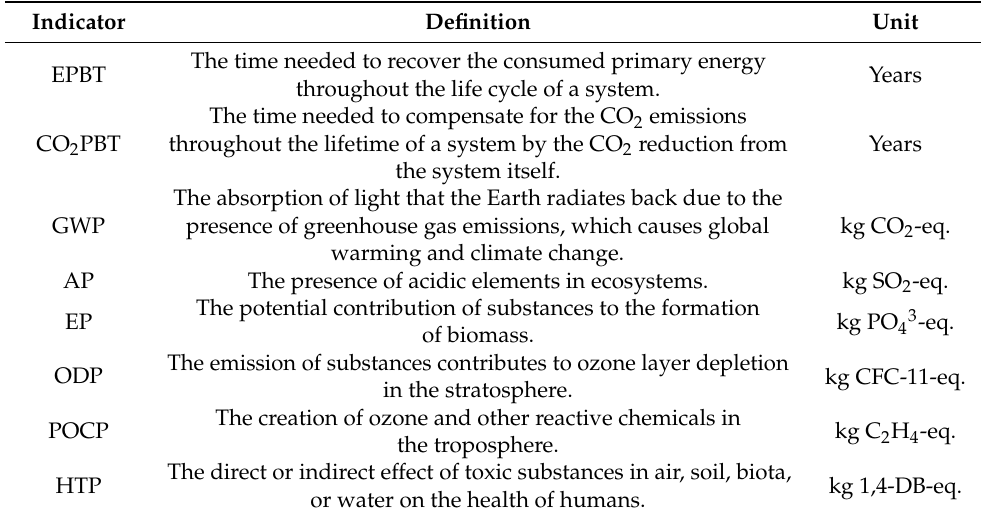
Table 1. List of the considered environmental indicators in this